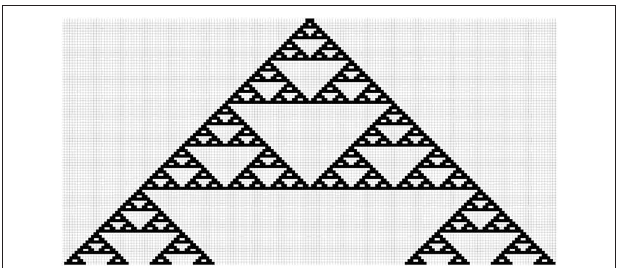
q 1, i.e., rule 126) from a = =